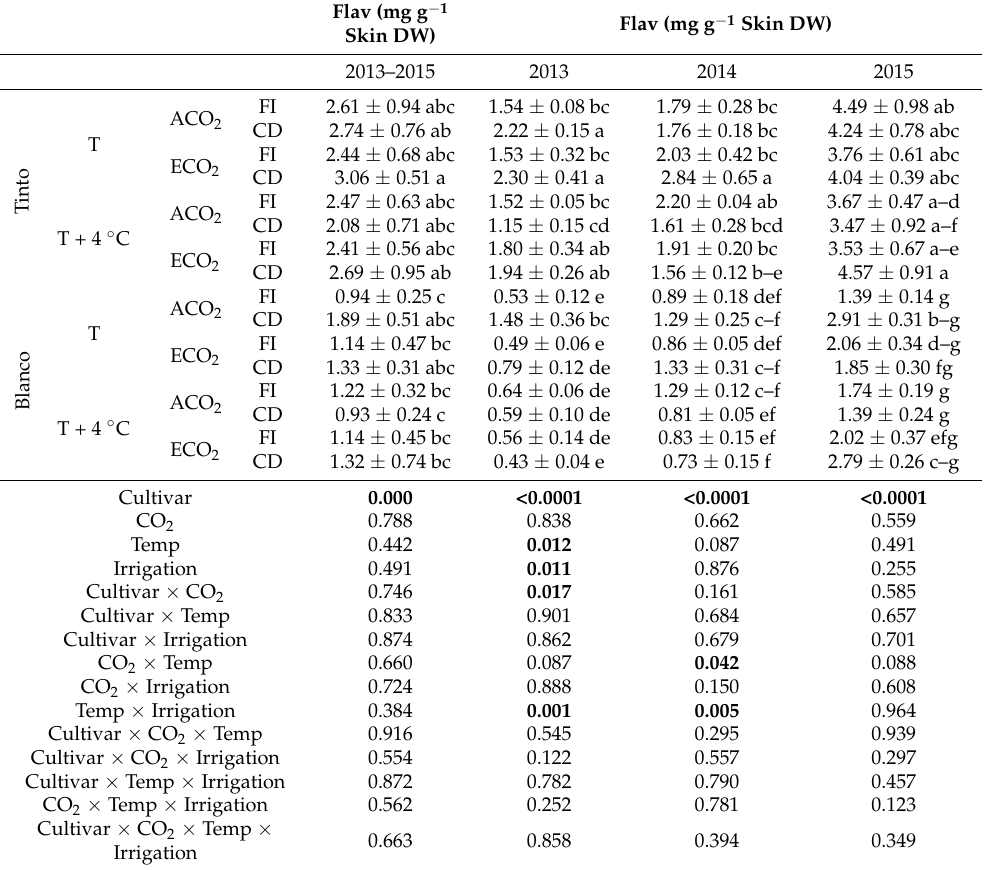
Table 1. Total flavonols (Flav) at maturity in Tempranillo Blanco and Tinto grapevine. Treatments used for growing the plants were as follows: ambient CO 2 concentration (ACO 2 , 400 ppm) versus elevated (ECO 2 , 700 ppm), ambient temperature (T) versus ambient + 4 ◦ C (T + 4 ◦ C), and full irrigation (FI) versus cyclic drought (CD). Significant differences ( p < 0.05) were based on LSD test (n = 3, mean ± SE) and are indicated by different letters. Means without letters or with common letters are not statistically different. Main factors and interactions ( p -values) that were not significant are not shown. Data were obtained by T. Kizildeniz during her PhD thesis following the procedure described in Hilbert et al.